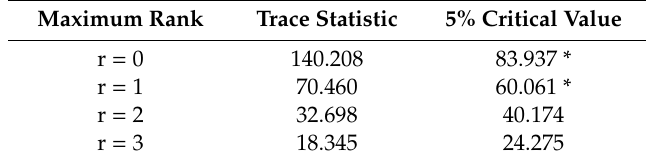
Table 7. The empirical results of the Johansen test for cointegration